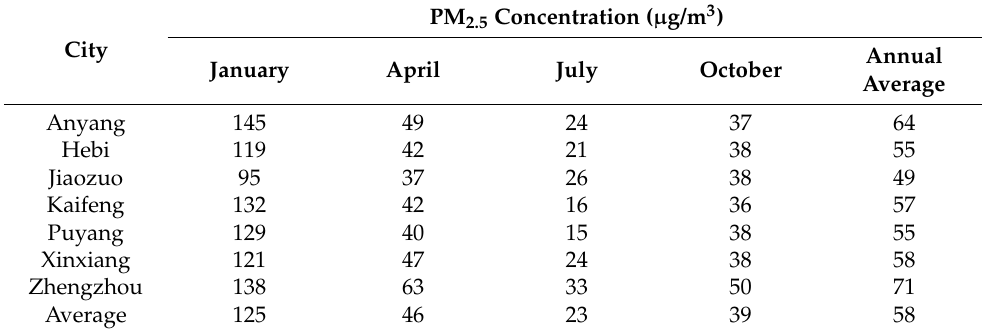
Table 6. PM 2.5 concentrations under the Green Upgrade scenario.